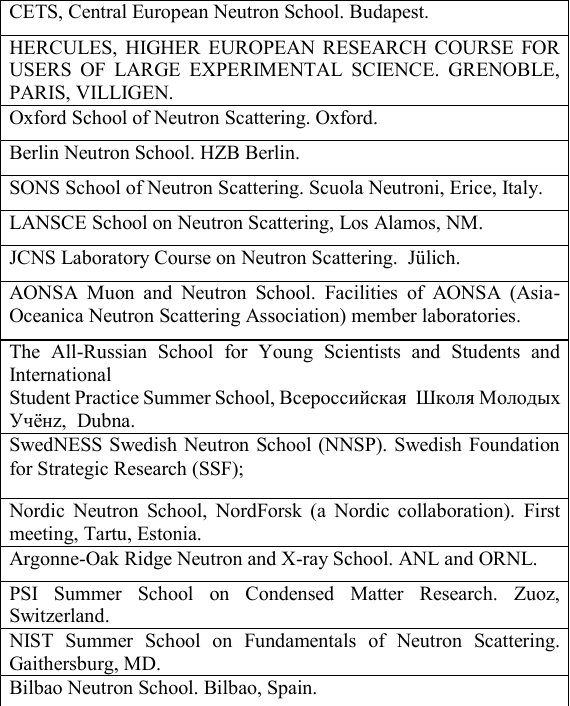
Table 1. A list of a few past neutron